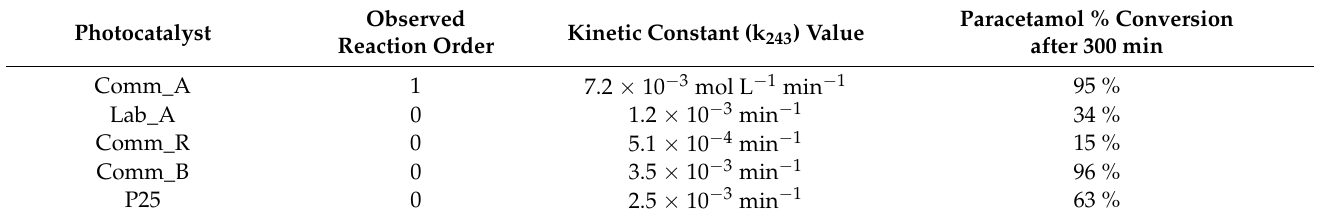
Table 3. Observed reaction order; kinetic constant values as determined by considering the intensity of the 243 nm band (k 243 ); total paracetamol conversion as determined by considering the intensity of the 243 nm band after 300 min during the photocatalytic tests with 0.15 g L − 1 powder in 0.01 mM paracetamol